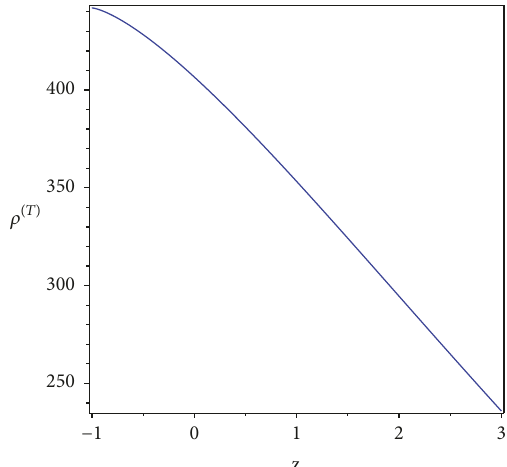
Figure5:Variationoftheeffectiveenergydensityversustheredshift for 𝑓(𝑇) = 𝑇 + 𝑛(𝑇 − 𝑇𝑒 (𝛽𝑇 0 /𝑇) + (−𝑇) 𝛽 ) . −1.100−1.050−1−0.950−0.900−0.850−0.800−0.750−0.700−0.650−0.600−0.550−0.500 W (T)